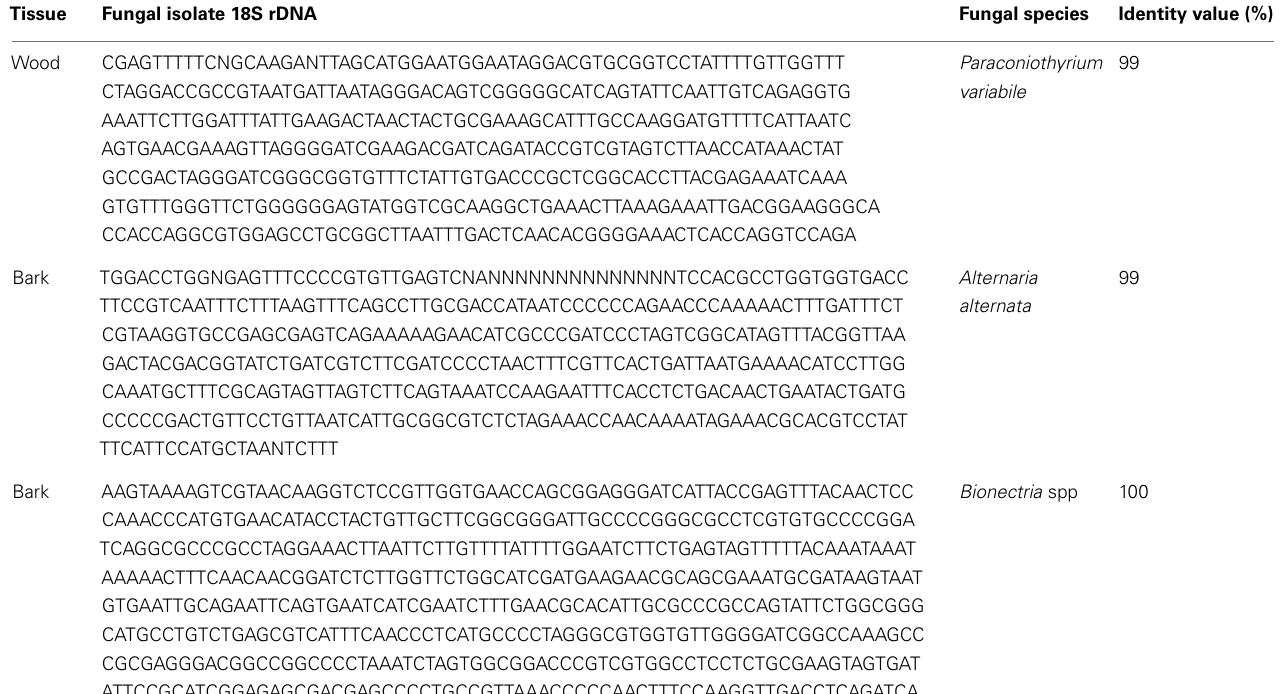
Table 2 | Sequences of fungal isolates from Taxus tissues and their taxonomic identities.